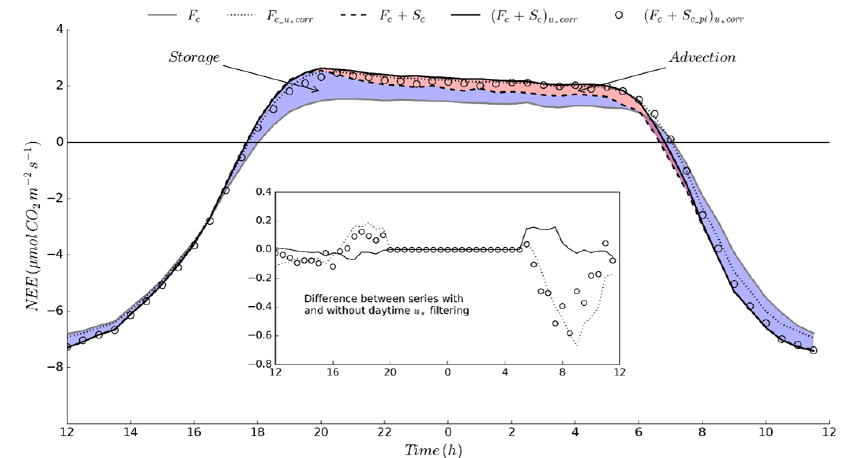
Figure 11. Effects of storage addition and diel u ∗ filtering on diel mean NEE dynamics (inset shows differences in NEE arising from application of diel versus nocturnal-only u ∗ filter; calculated as nocturnal-filtered series subtracted from diel-filtered